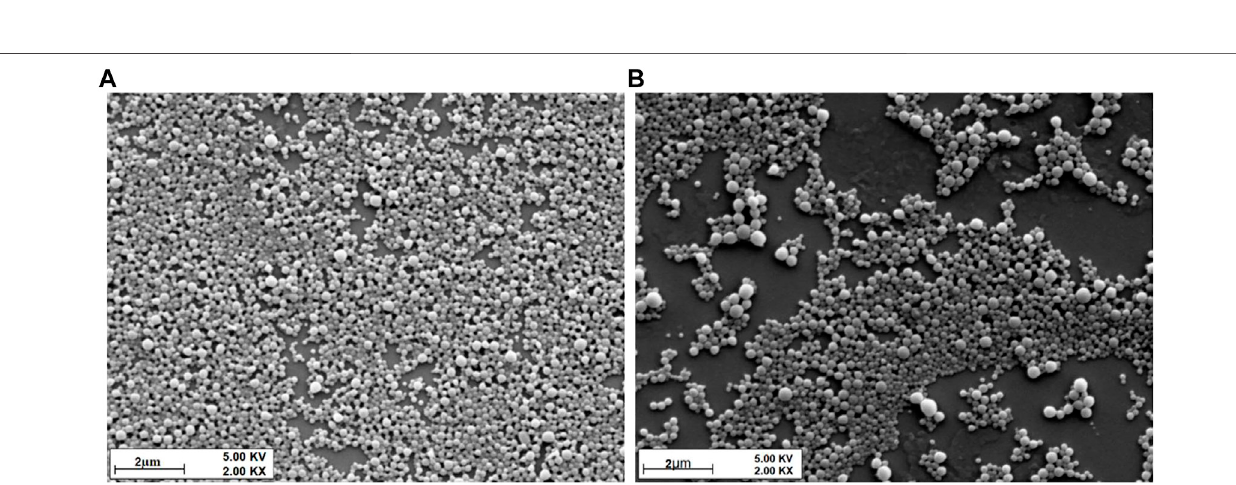
TABLE 5 | Physicochemical characteristics of Carbopol 934P-NF gel base.